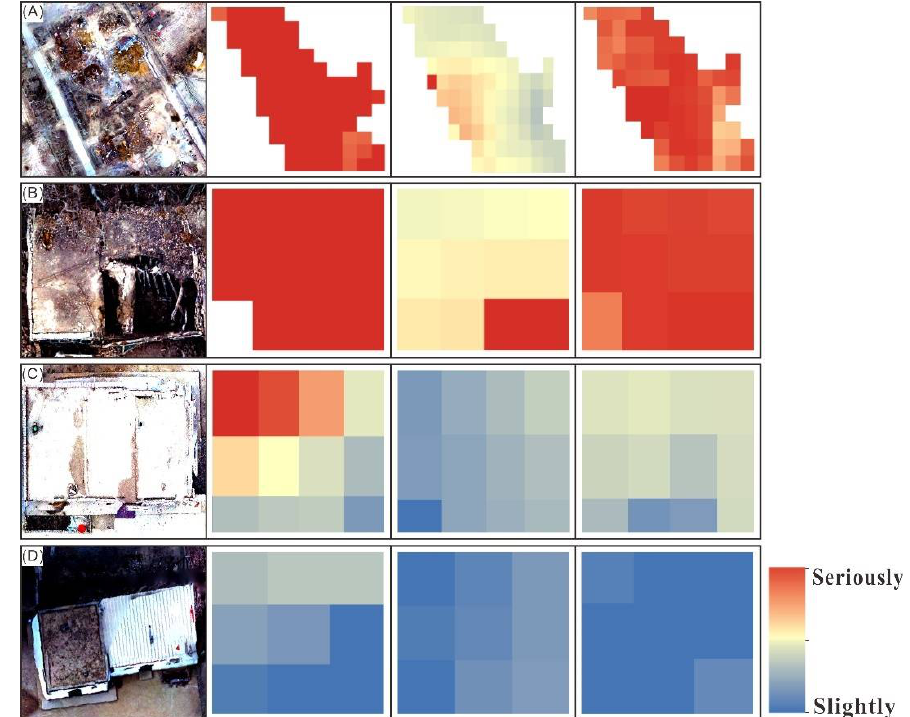
Figure 13. Comparison of the results of the three methods. The first column is an example of UAV sampling: ( A ) collapsed building; ( B ) severely damaged building; ( C ) lightly damaged building; ( D ) undamaged building. The second column is the coherent change detection result corresponding to the first column. The third column is the polarization decomposition result corresponding to the first column. The fourth column is the result of the comprehensive detection method corresponding to the first column.